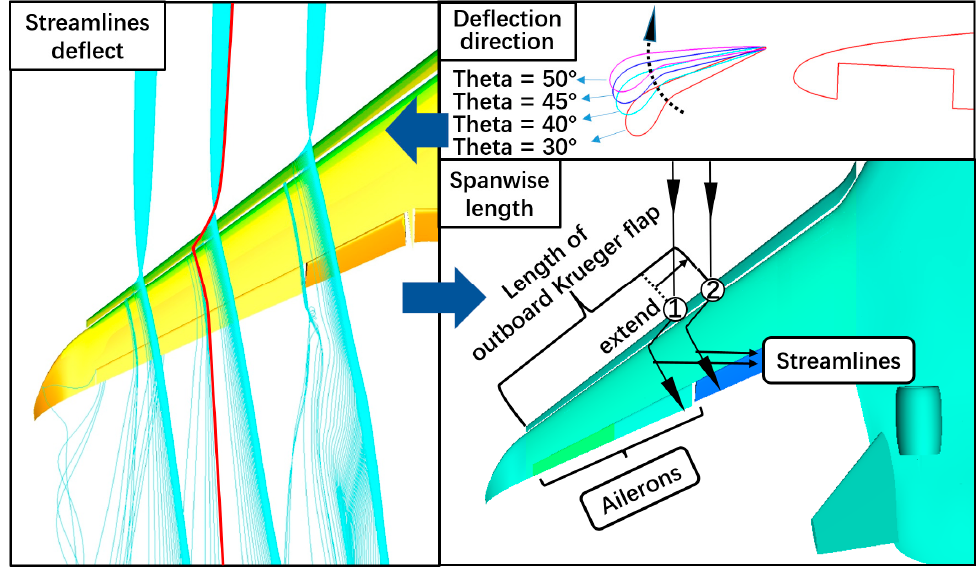
Figure 13. Sensitivity analysis parameter definition and initialization.